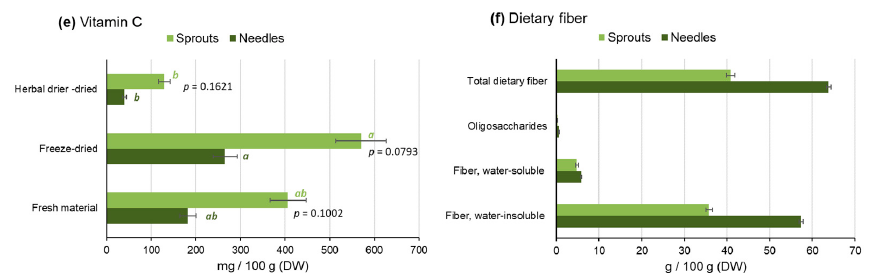
Figure 1. Quantitative analysis results of basic properties of sprouts and needles of Norway spruce: macro-components ( a ), carbohydrate composition ( b ), minerals ( c ), vitamin A and B 9 precursors ( d ), vitamin C ( e ), and dietary fiber ( f ). Note: vitamin C content is shown for differently treated raw materials ( e ). The error bars indicate the standard deviations. The p -values for statistical difference between sprouts and needles are presented. Different letters in ( e ) refer to statitistically signficiant ( p < 0.05) differences in vitamin C content of sprouts (light green) and needles (dark green) between different drying methods.